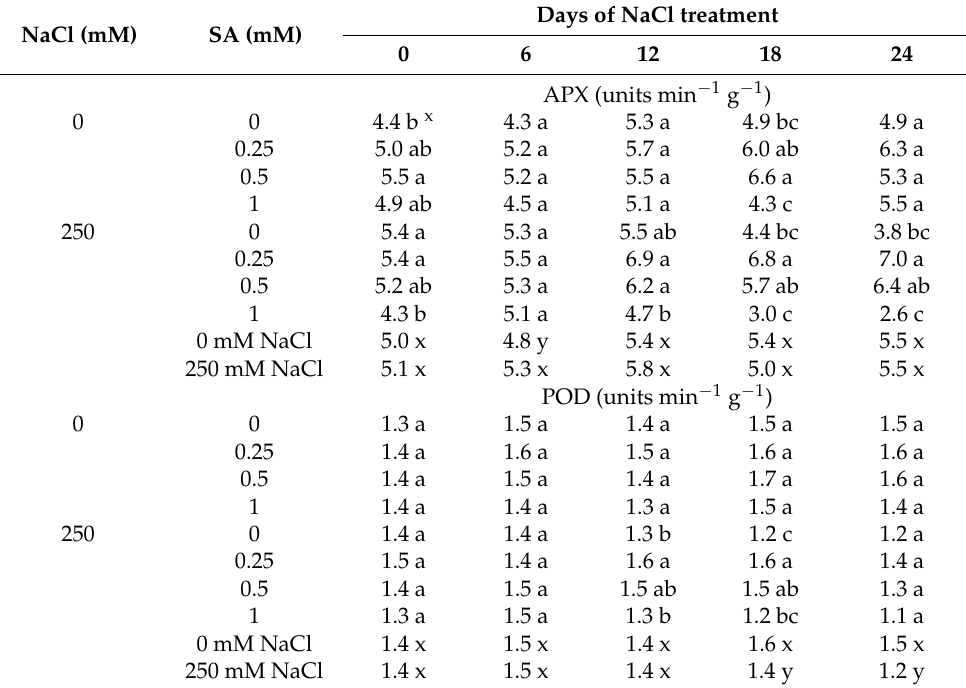
Table 5. Effect of salicylic acid on APX and POD activity of perennial ryegrass under two salt conditions.